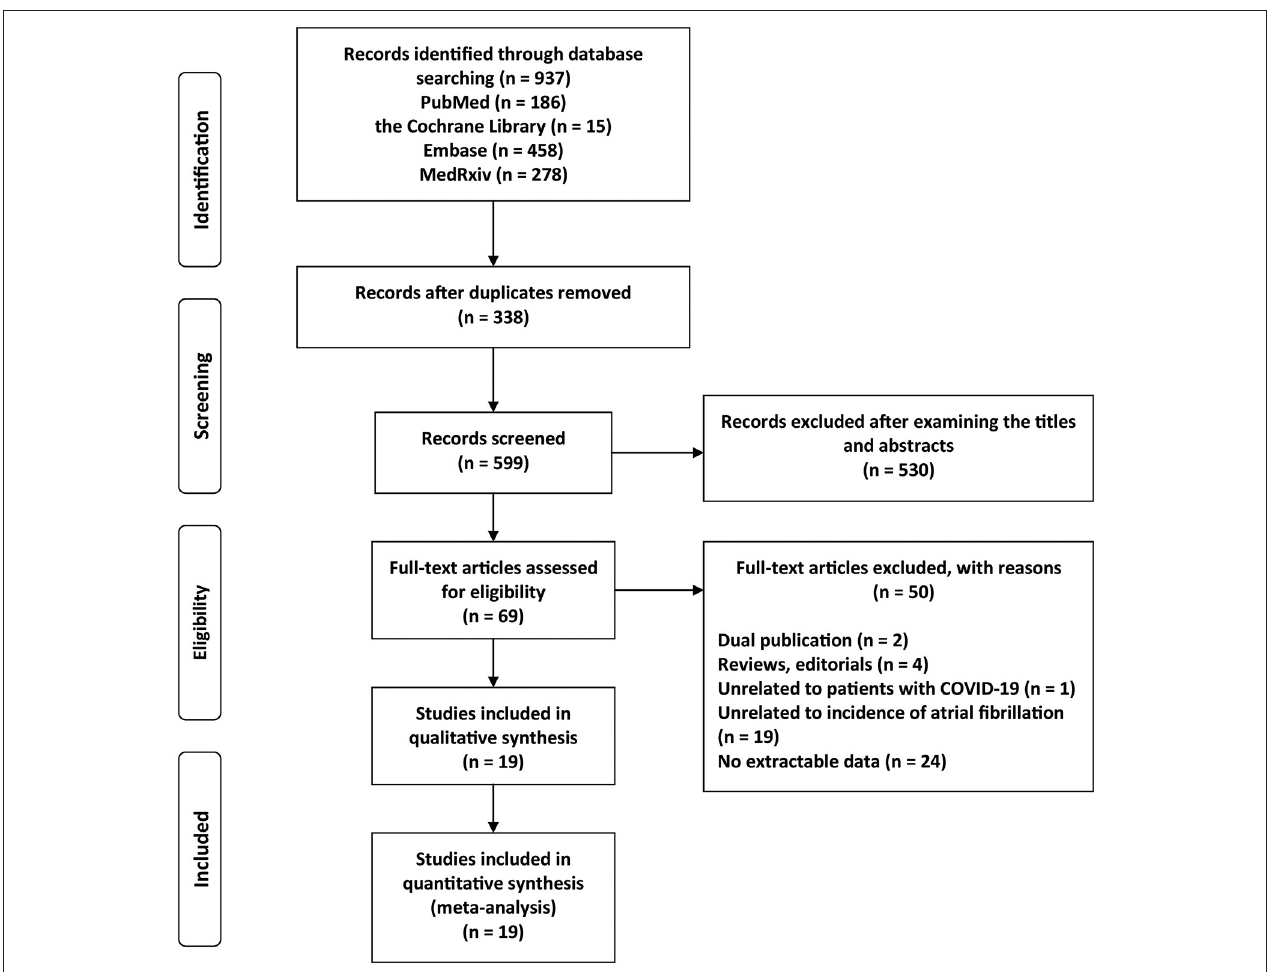
FIGURE 1 | Flow chart of the study selection